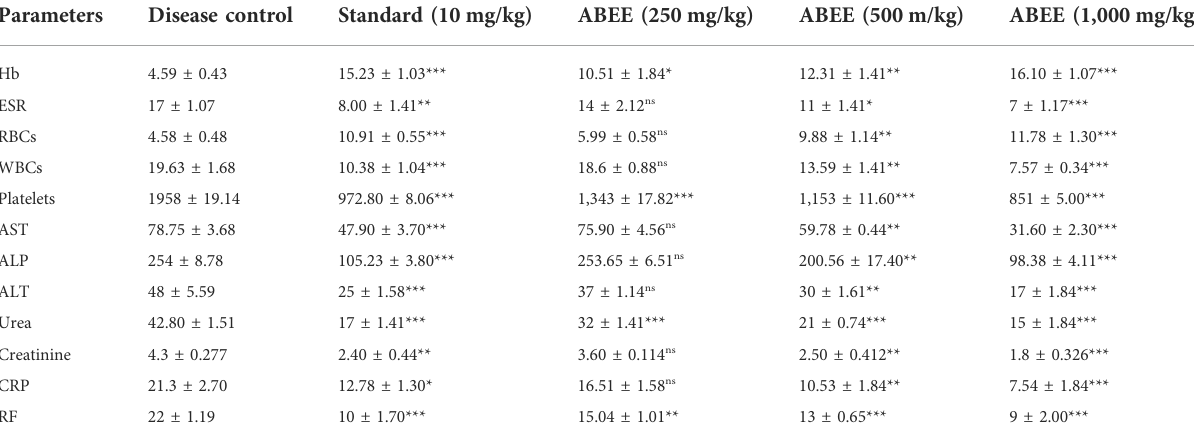
TABLE 7 Effects Of ABEE on hematological and biochemical variables of formaldehyde-induced arthritic rats. Parameters